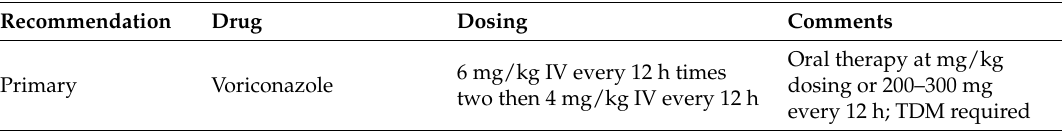
Table 1. Treatment recommendations for invasive